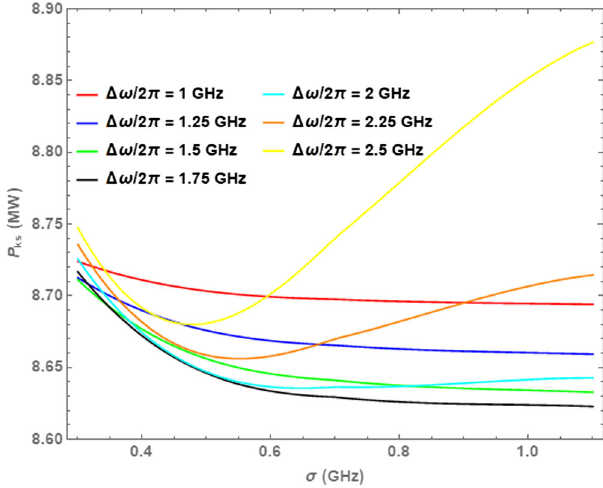
FIG. 21. The klystron power per structure for a range of Δ ω where L ¼ 0 . 5 m and h G i ¼ 80 MV = m for this